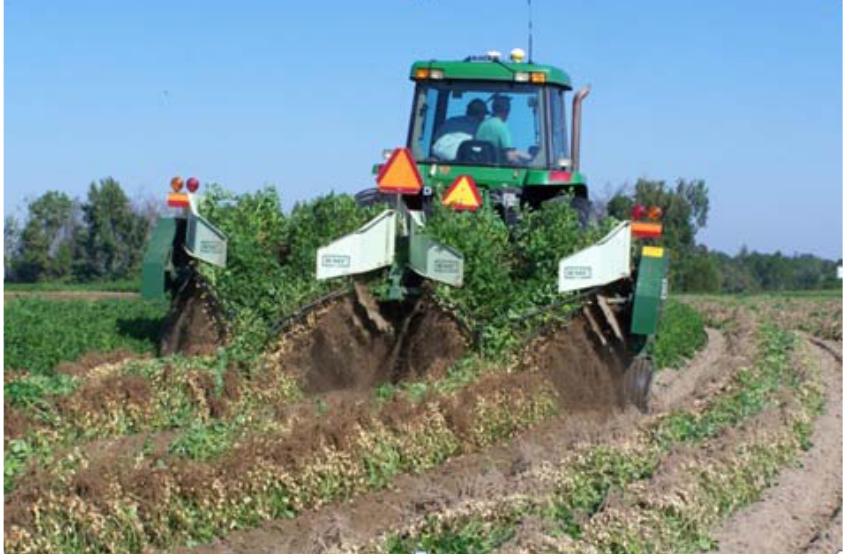
Figure 4. Inverting peanuts with a 4-row KMC (Kelley Manufacturing Company, Tifton, GA, USA) peanut inverter pulled by the University of Georgia (UGA) tractor equipped with a Trimble ® AgGPS Autopilot™ auto-steer